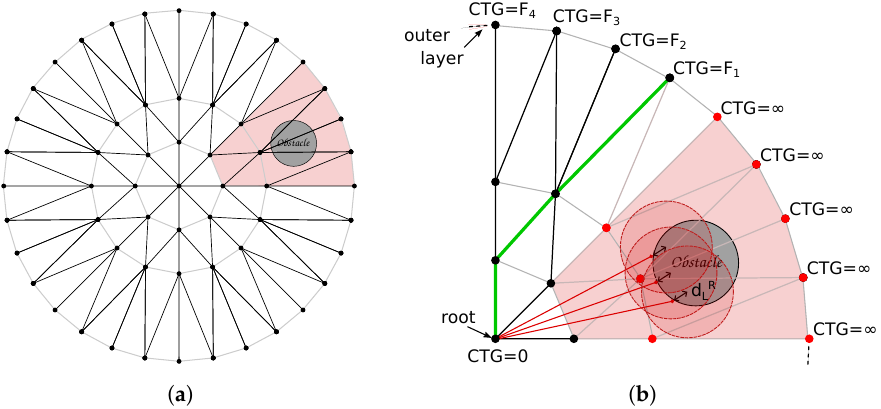
Figure 7. Collision detection approach. ( a ) The lattice is triangulated to facilitate collision detection. The edges of the lattice are shown in black and the edges completing the triangles are shown in gray. ( b ) Detailed view of ( a ). In red, the range sensor (e.g., LIDAR) measurements are transformed into circles in the sensor space that account for the robot dimensions. The triangles painted in light red overlap with these circles and have their edges pruned from the graph. The motion planning algorithm chooses the path, shown in green, from the remaining edges that minimizes the cost-to-go (CTG) from root to the outer